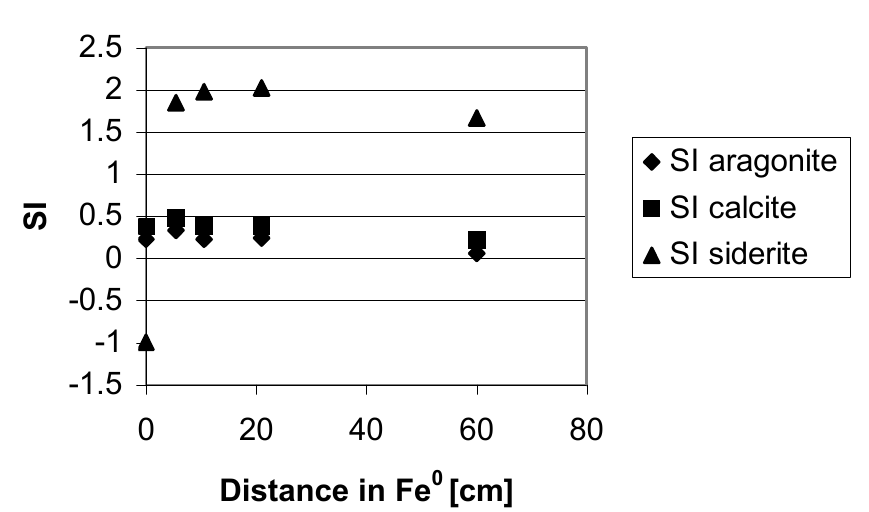
Fig. 5 SI values for selected